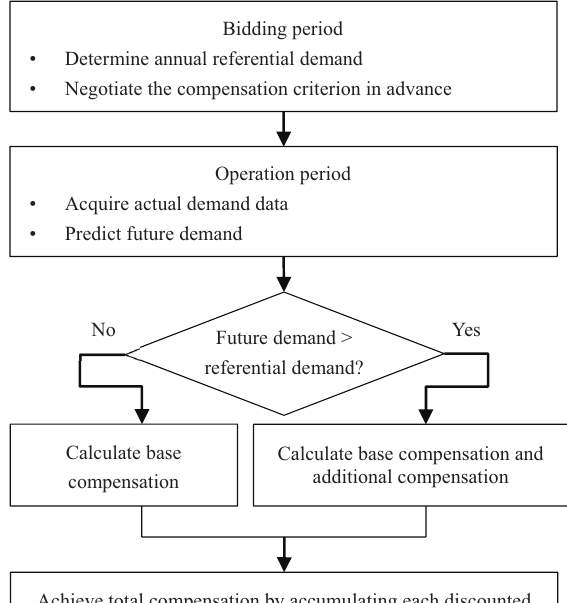
Figure 2. Framework of compensation